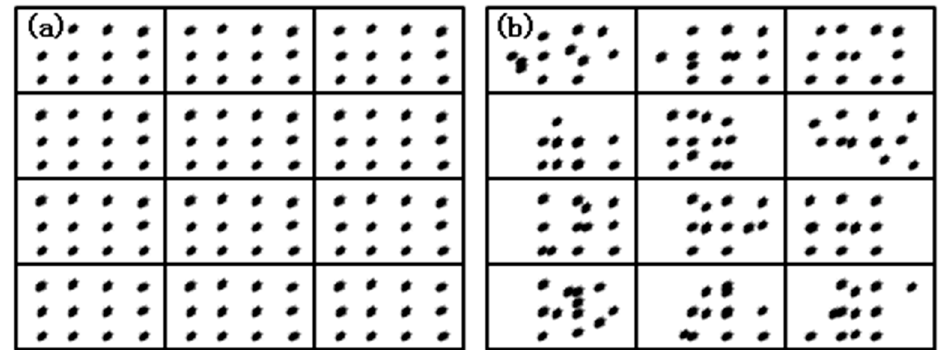
Figure 3. Schematic diagram of distribution about particles in micro zone under the same S (cid:48) r and different β . ( a ) β = 0 and ( b ) β >0) .